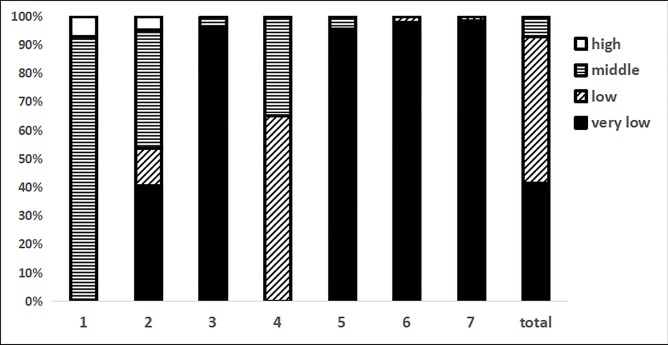
The distribution of domain scores.